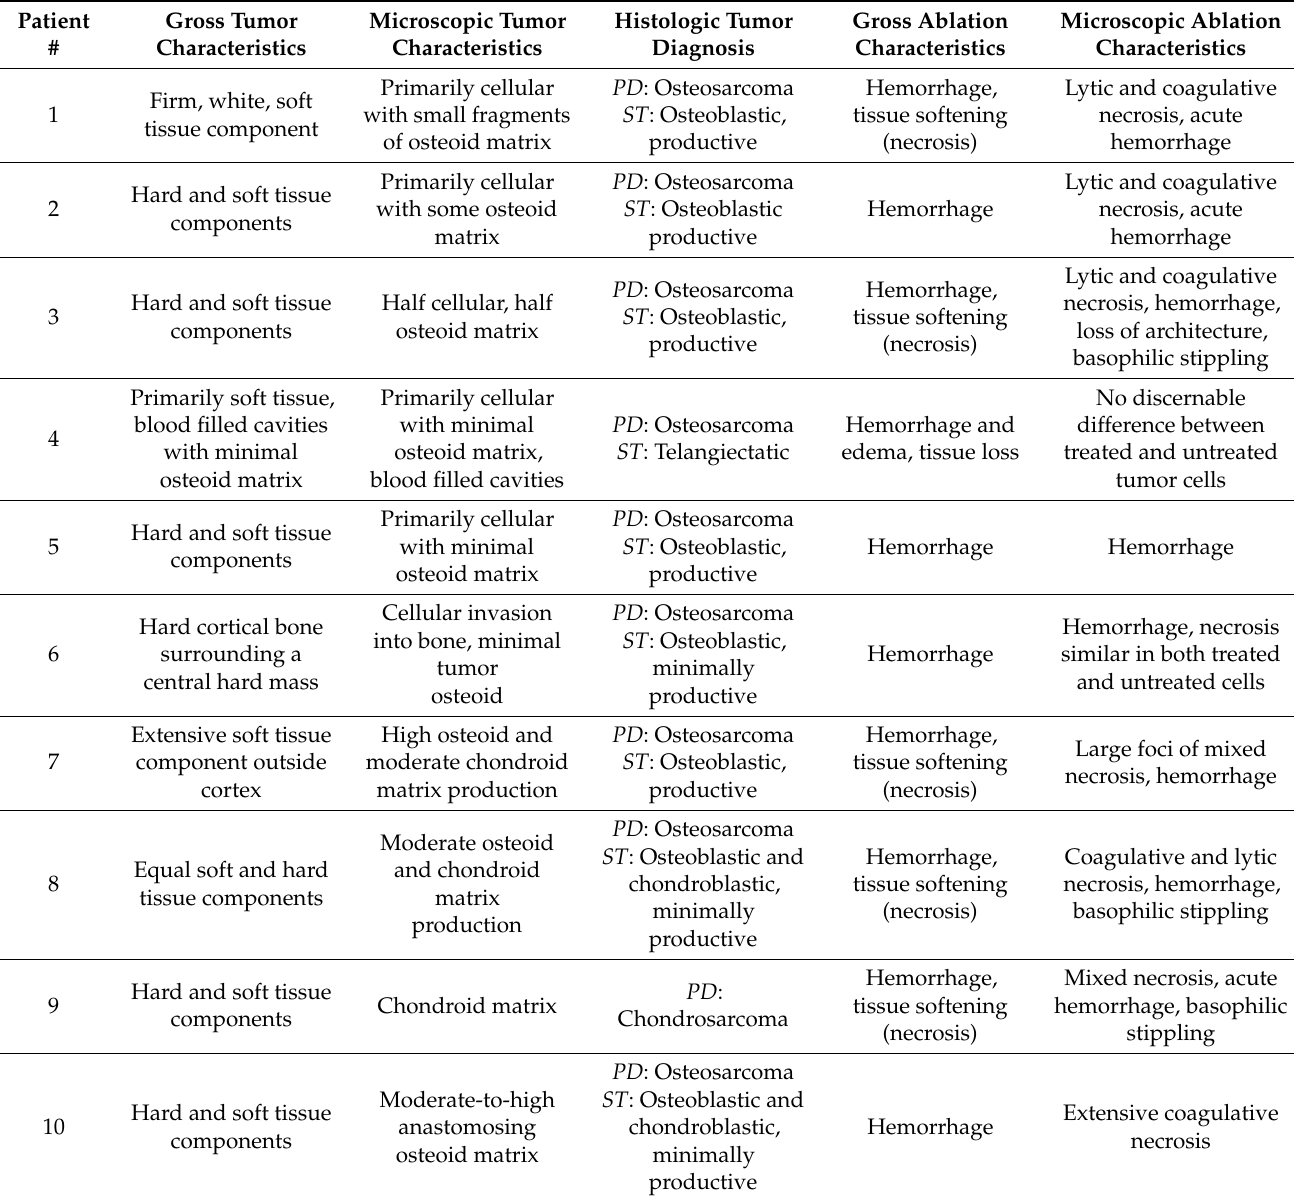
Table 5. Gross and microscopic (i.e., histologic) tumor observations pre- and post-histotripsy